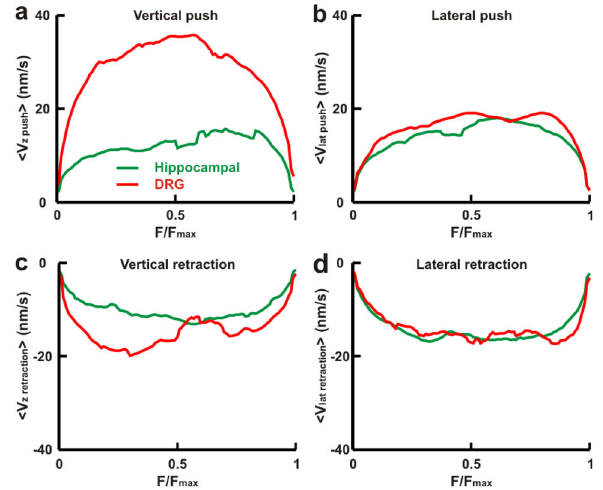
Figure 1. Fv relationships during pushes and retractions from hippocampal and DRG lamellipodia. ( a – d ) Average Fv relationships, < Fv > , normalized to F for vertical pushes ( a ), 0.2 max lateral pushes ( b ), vertical retractions ( c ) and lateral retractions ( d ) for hippocampal and DRG lamellipodia. The numbers of individual Fv relationships averaged in DRG and in hippocampal neurons were equal to ( a ) 23, 14, respectively; ( b ) 20, 34, respectively; ( c ) 23, 14, respectively; and ( d ) 14, 14, respectively. DRG data are taken from our previous work [23]. doi: hippocampal filopodia equal to 3.0 ±0.1 pN (n=64) (Figure 2 i). Often filopodia could seal on the silica bead, so that when they retracted they pulled the bead away from the optical trap, exerting a force during their retraction. During retractions both DRG and hippocampal filopodia exerted a force significantly larger than during protrusion, equal to 5.0±0.5 (n=31) and 5.3±0.7 pN (n=23), respectively (Figure 2 j).